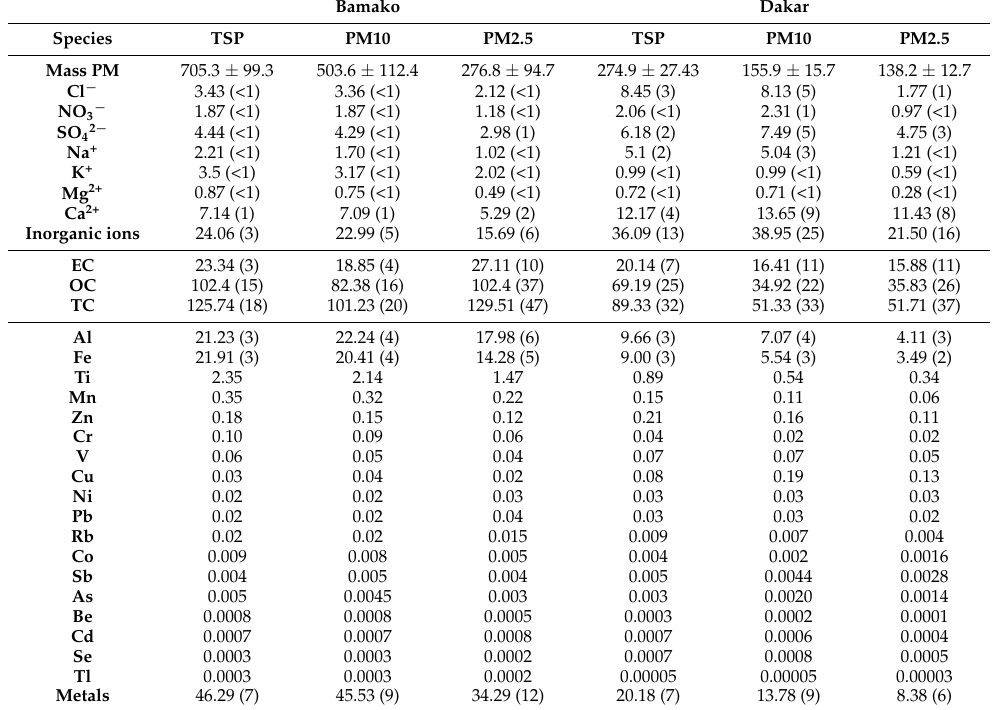
Table 1. Average 24 h concentrations (in µ g.m − 3 ) for TSP, PM 10 , and PM 2.5 and associated elemental compositions in Bamako (including dust episode) and Dakar. Values in parentheses are percentages in total masses. Bamako Dakar Species TSP PM10